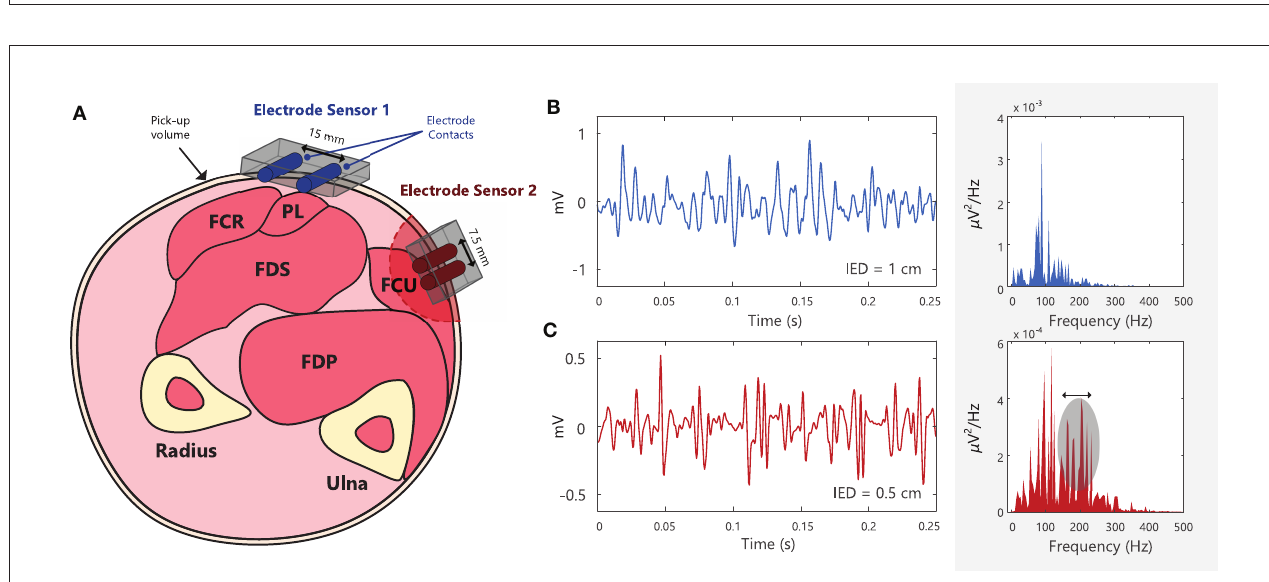
FIGURE 5 | of 10Hz shown in the time and frequency domain, y(t) and Y(f), respectively. As a non-sinusoidal wave, it contains frequency components at multiples of the first harmonic (note: triangle waves contain only odd harmonics). See Example (iii) in Tutorial Code. (C) The firing of a single motor unit over 2s, shown in the time and frequency domain. The motor unit fires at an average frequency of 12Hz (fundamental frequency of the spike train), but spectral peaks at multiples of 12Hz can be observed in the frequency domain. (D) A 0.25s EMG signal in the time and frequency domain. The length of the signal determines the frequency resolution (1/T r =